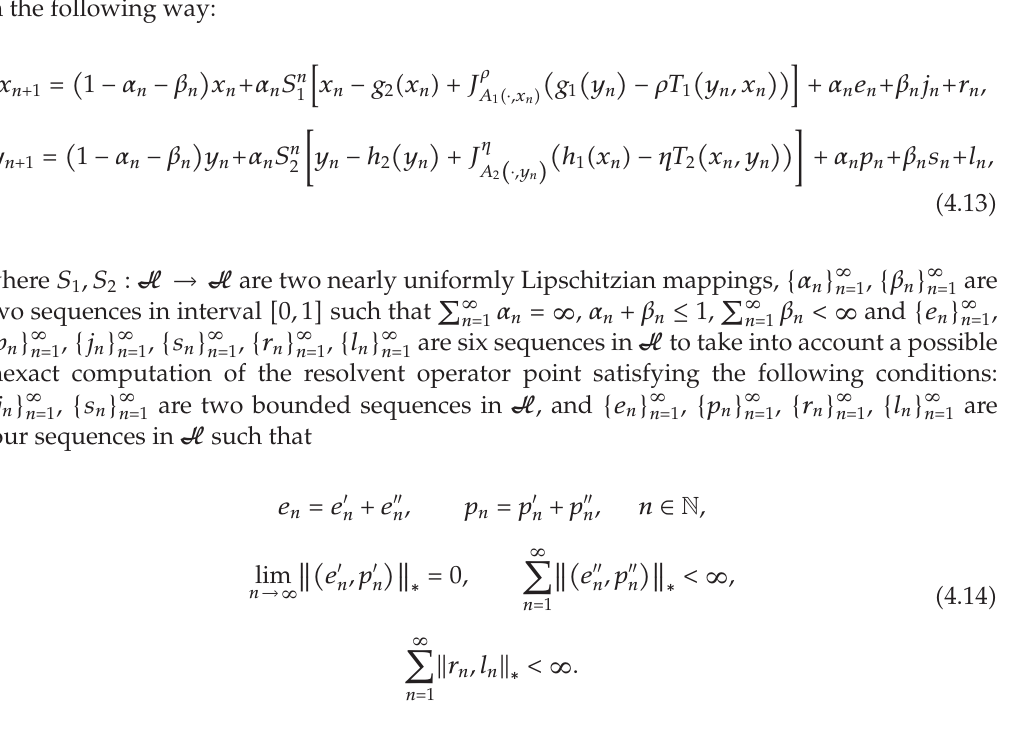
Algorithm 4.3. Let T i , A i , g i , h i (cid:6) i (cid:8) 1 , 2 (cid:7) , ρ , and η be the same as in the system (cid:6) 2.4 (cid:7) . For